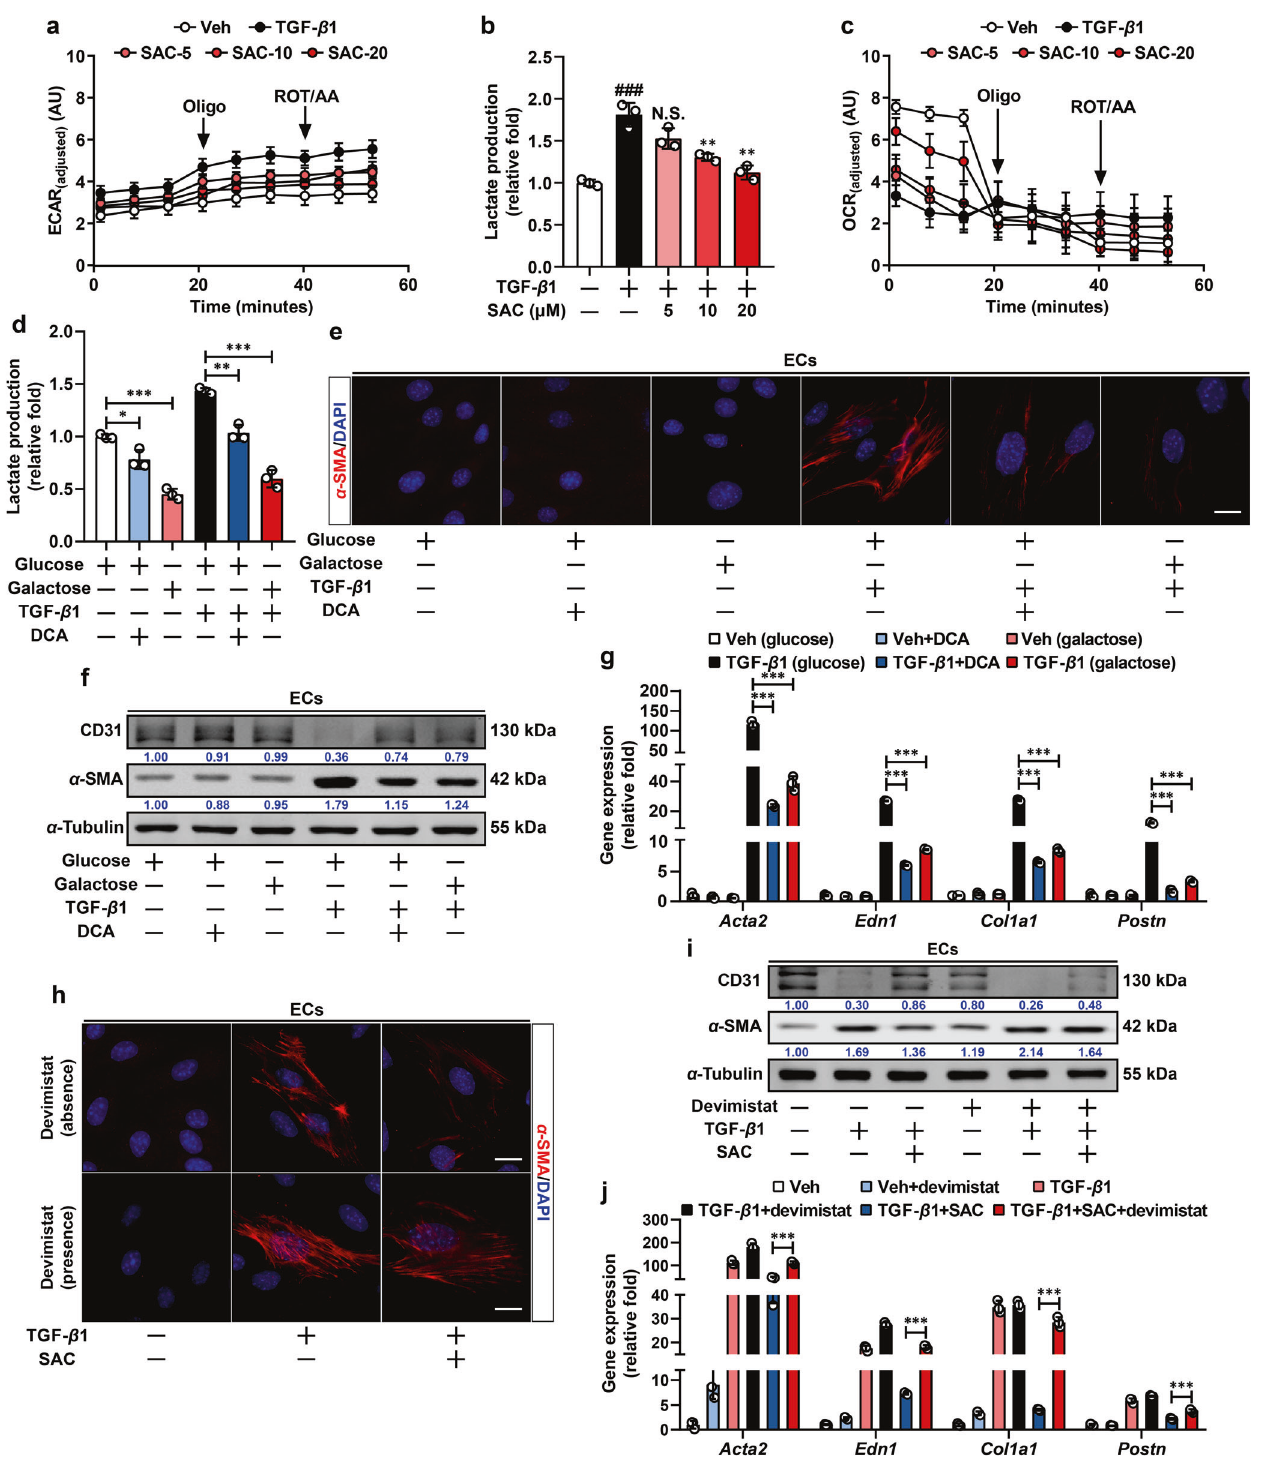
Fig. 2 SAC attenuates EndoMT via restoration of imbalanced glycolytic/mitochondrial metabolism. a , b Analysis of ECAR and lactate production in ECs treated with vehicle, TGF- β 1 and SAC ( n = 3). c Analysis of OCR in ECs treated with vehicle, TGF- β 1 and SAC ( n = 3). d Lactate production in ECs treated with vehicle, TGF- β 1, DCA, and galactose ( n = 3). e Immuno fl uorescent staining of α -SMA in ECs treated with vehicle, TGF- β 1, DCA and galactose, scale bar, 20 μ m ( n = 3). f Immunoblot analysis of CD31 and α -SMA expression in ECs treated with vehicle, TGF- β 1, DCA and galactose. α -Tubulin was used as the loading control ( n = 3). g q-PCR analysis of Acta2 , Edn1 , Col1a1 and Postn mRNA level in ECs treated with vehicle, TGF- β 1, DCA, and galactose. 18s RNA was used as the internal reference ( n = 3). h Immuno fl uorescent staining of α -SMA in ECs treated with vehicle, TGF- β 1, SAC, and devimistat, scale bar, 20 μ m ( n = 3). i Immunoblot analysis of CD31 and α -SMA expression in ECs treated with vehicle, TGF- β 1, SAC, and devimistat. α -Tubulin was used as the loading control ( n = 3). j q-PCR analysis of Acta2 , Edn1 , Col1a1 , and Postn mRNA level in ECs treated with vehicle, TGF- β 1, SAC and devimistat. 18s RNA was used as the internal reference ( n = 3). Data are represented as mean ± SD. ### p < 0.001 versus control group. ** p < 0.01, *** p < 0.001 versus model group ( b ) or indicated group Signal Transduction and Targeted Therapy (2022)